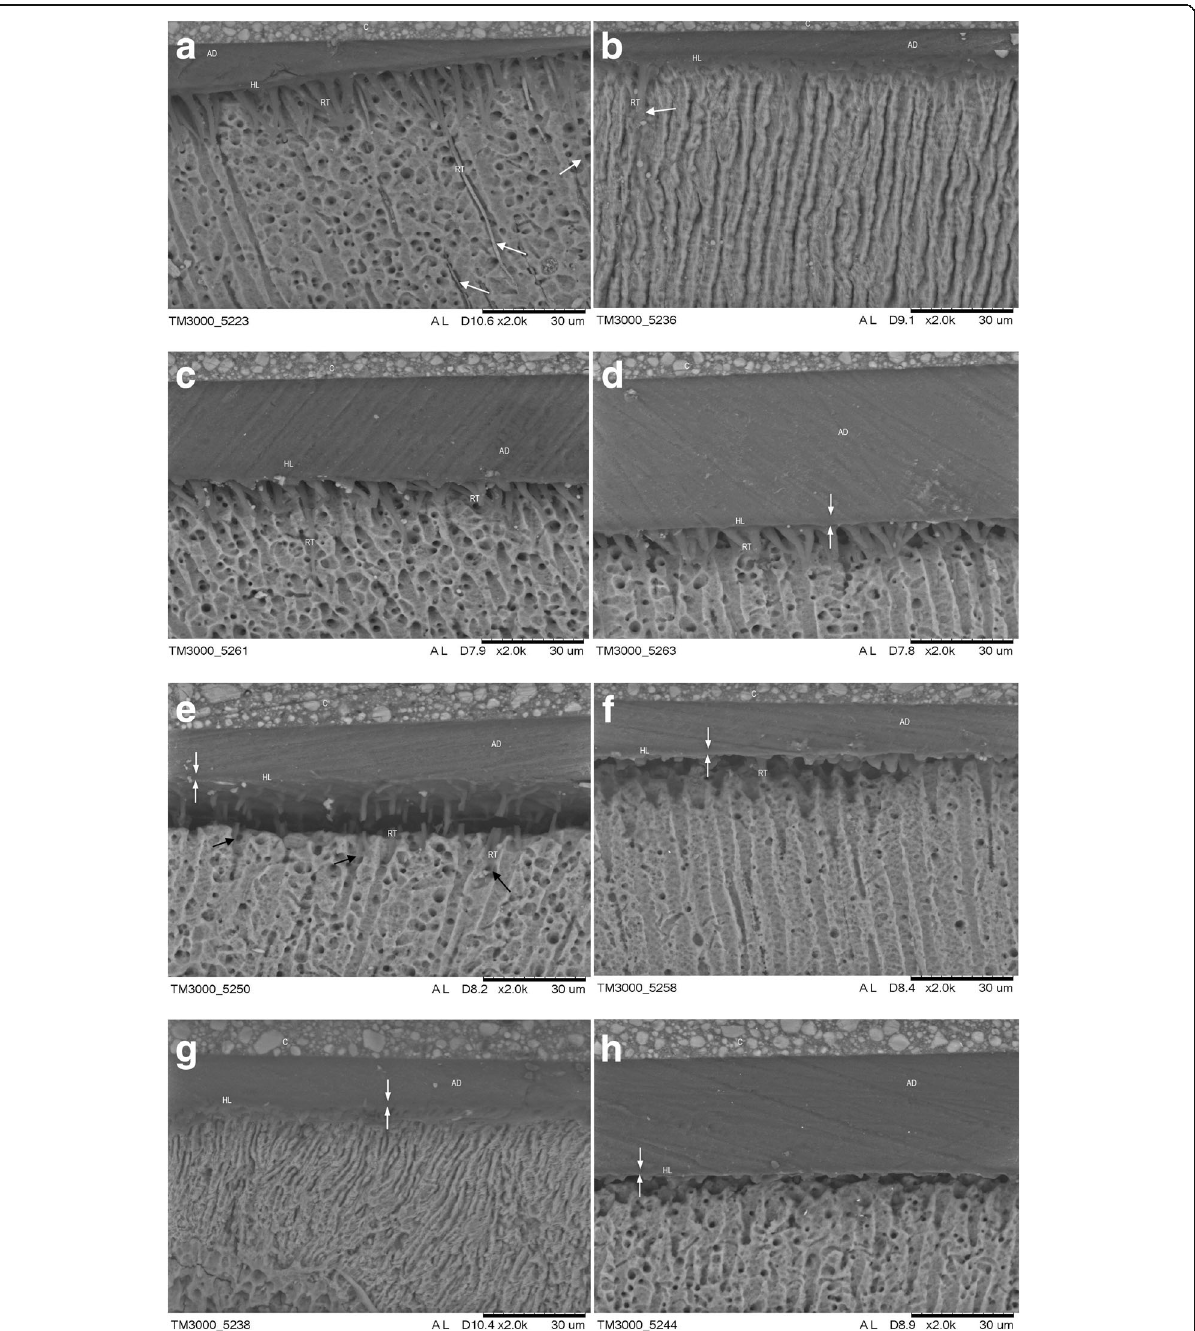
Fig. 6 Scanning electron micrographs show the bonded interface of the experimental and control groups. Resin tag quantity and quality match the bond strength results (MPa). White arrows point toward the hybrid layer. C, composite resin; HL, hybrid layer; RT, resin tags; AD, adhesive resin. A uniform hybrid layer with long well-formed resin tags was observed in the control ( a ) and CHX ( b ) groups. RP3 specimens before etching ( c ) and after etching ( d ) show a thin hybrid layer, and relatively shorter resin tags were identified compared with the control group. Representative SEM images of the resin-dentin interface from the RP6 group applied before etching ( e ) and after etching ( f ) show that a very thin hybrid layer was created (white arrows). Short resin tags were identified inside the dentin tubules (E, black arrows). Hardly any hybrid layer could be observed in RP1 specimens. Lack of well-formed resin tags was observed regardless of whether dentin treatment with micellar nanocomposites loaded with EARP was done before ( g ) or after etching ( h ). Only a few very short resin tags can be